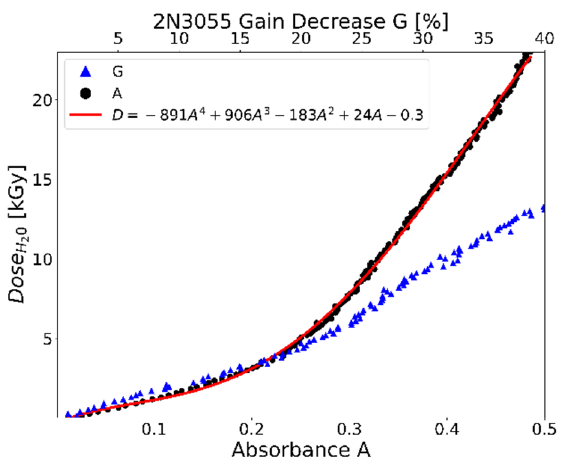
Figure 10. The dose measured with the ionization chamber versus the absorbance increase, A , of the HDV-2 gafchromic film at 980 nm (black) and the gain , G , decrease of the transistor (blue). For this application, the absorbance curve A is fitted with a fourth-order polynomial function, D (red line).